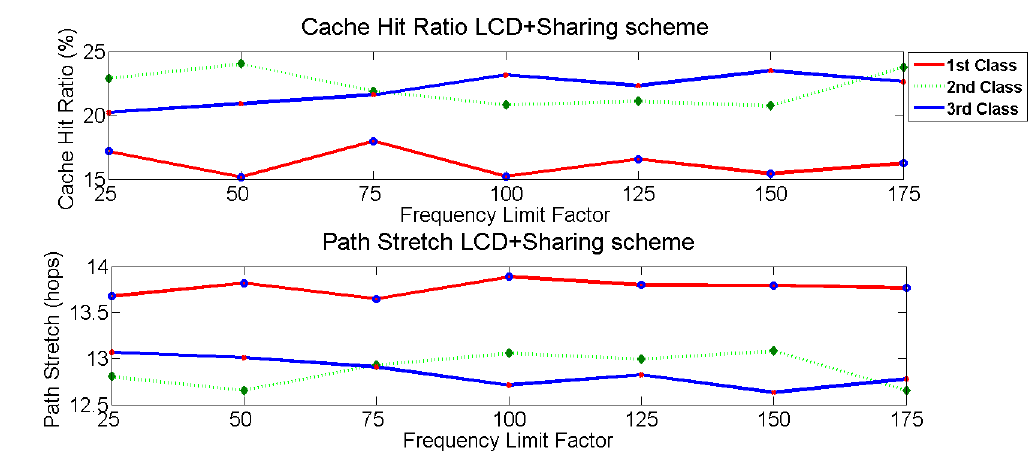
Figure 14. Performance of LCD+sharing